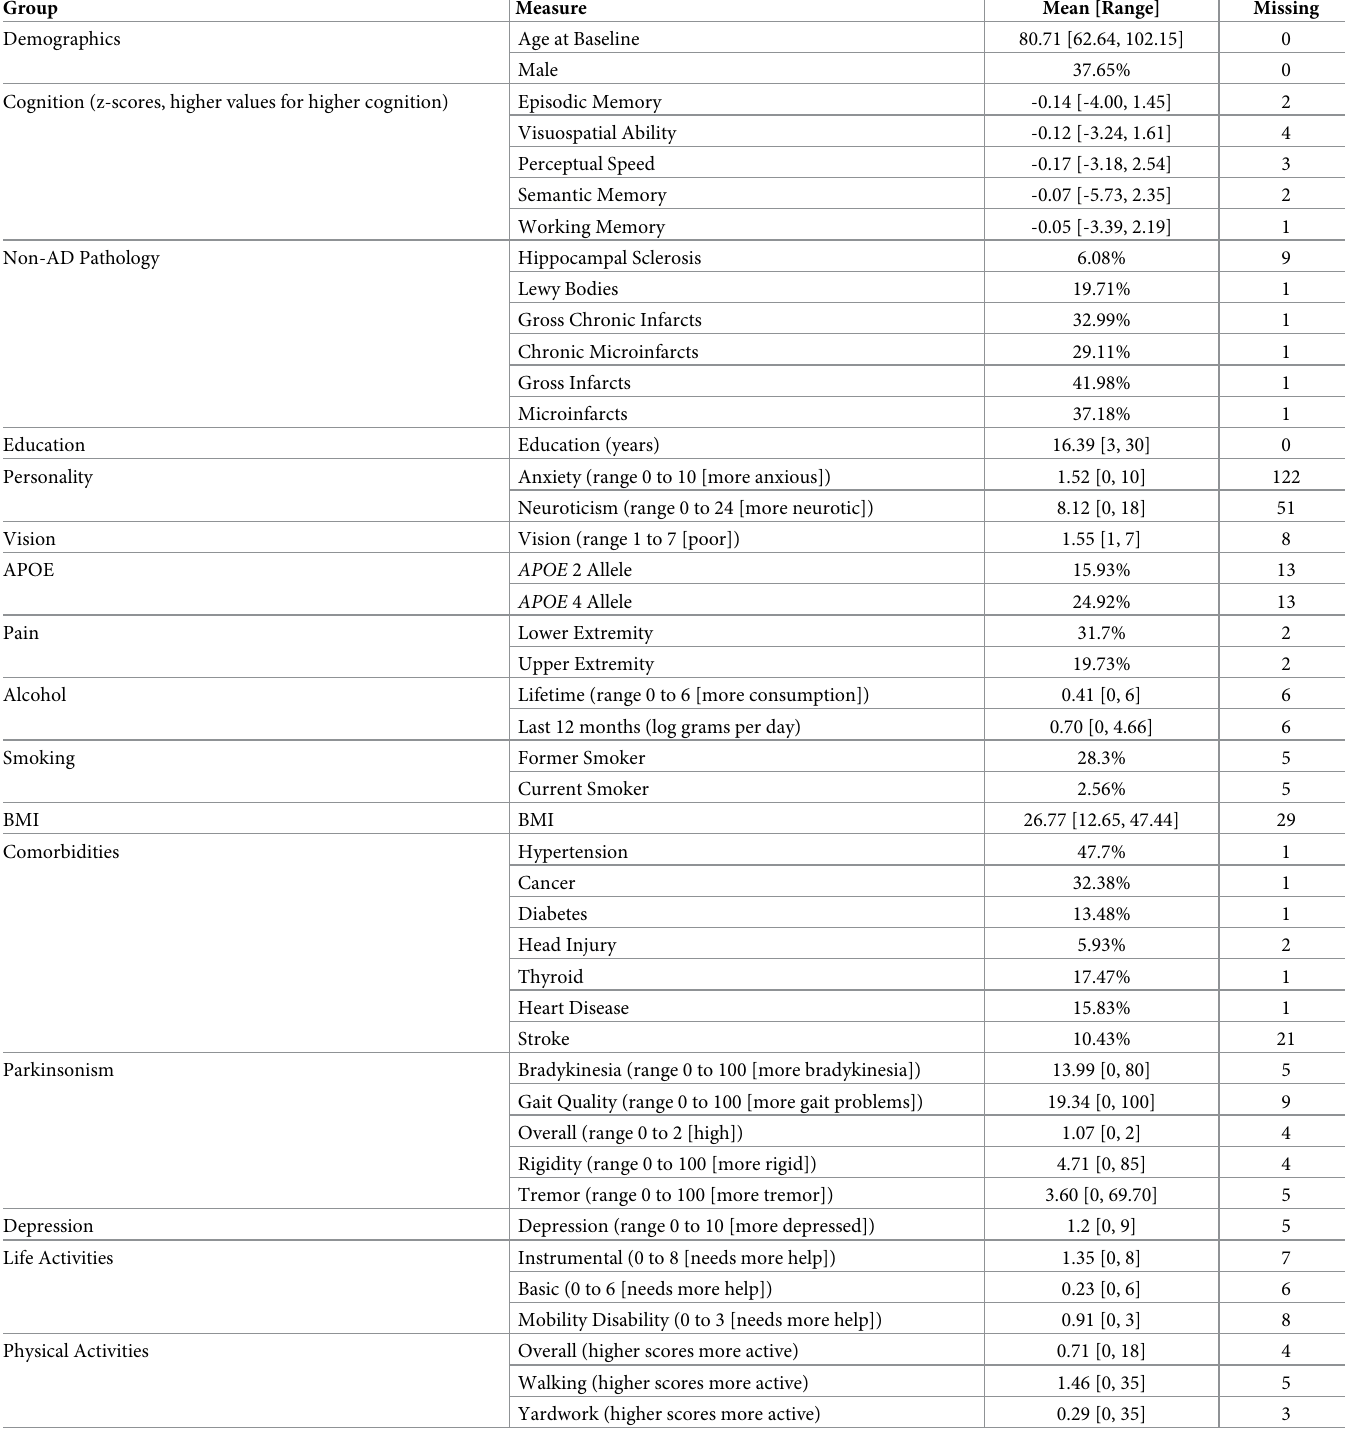
Table 2. Summary of the measures that make up each of the groups for the